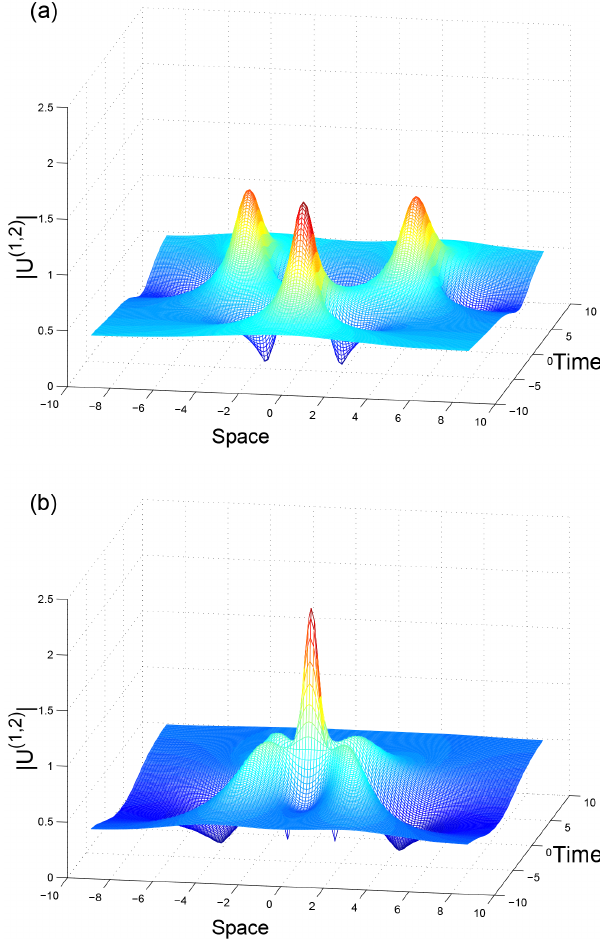
Figure 1. Amplitude of the one-mode SPB over an unstable plane wave with two UMs: (a) U ( 1 ) (x,t ; ρ) and (b) U ( 2 ) (x,t ; ρ) . mode,